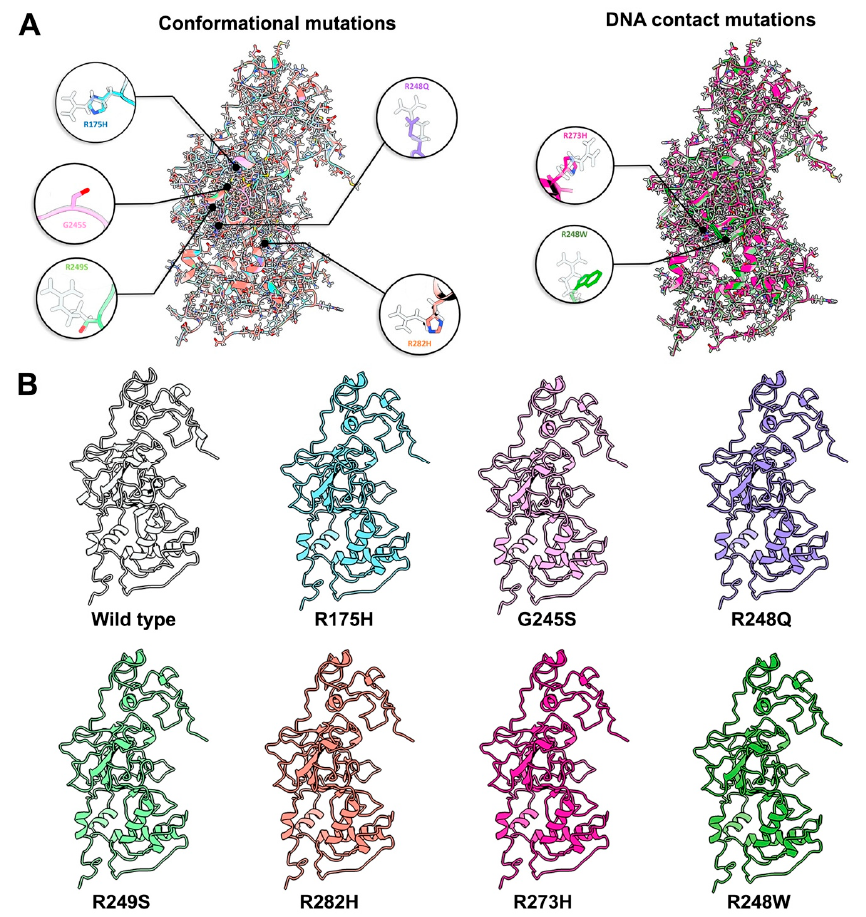
Figure 2. Molecular models of frequently occurring hotspot mutations in p53. ( A ) Overlay of molecular models containing hotspot mutations that affect local protein conformation or DNA contacts. Individual amino acids changes are magnified. The p53 WT model (pdb code, 8F2I) is shown in white for comparison. ( B ) Within the central DBD of p53 hotspot mutations include R175H (light blue, Movie S2), G245S (pink, Movie S3), R248Q (purple, Movie S4), R249S (light green, Movie S5), R282H (orange, Movie S6), R273H (magenta, Movie S7) and R248W (dark green, Movie S8). Percent sequence identities for each mutant was 99.75% compared with WT.